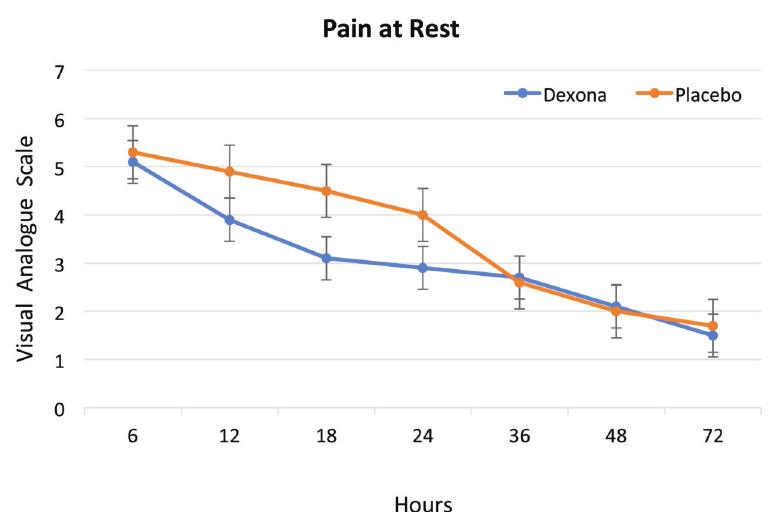
Level of pain at rest within 72 hours of anterior cruciate ligament Fig. 2: